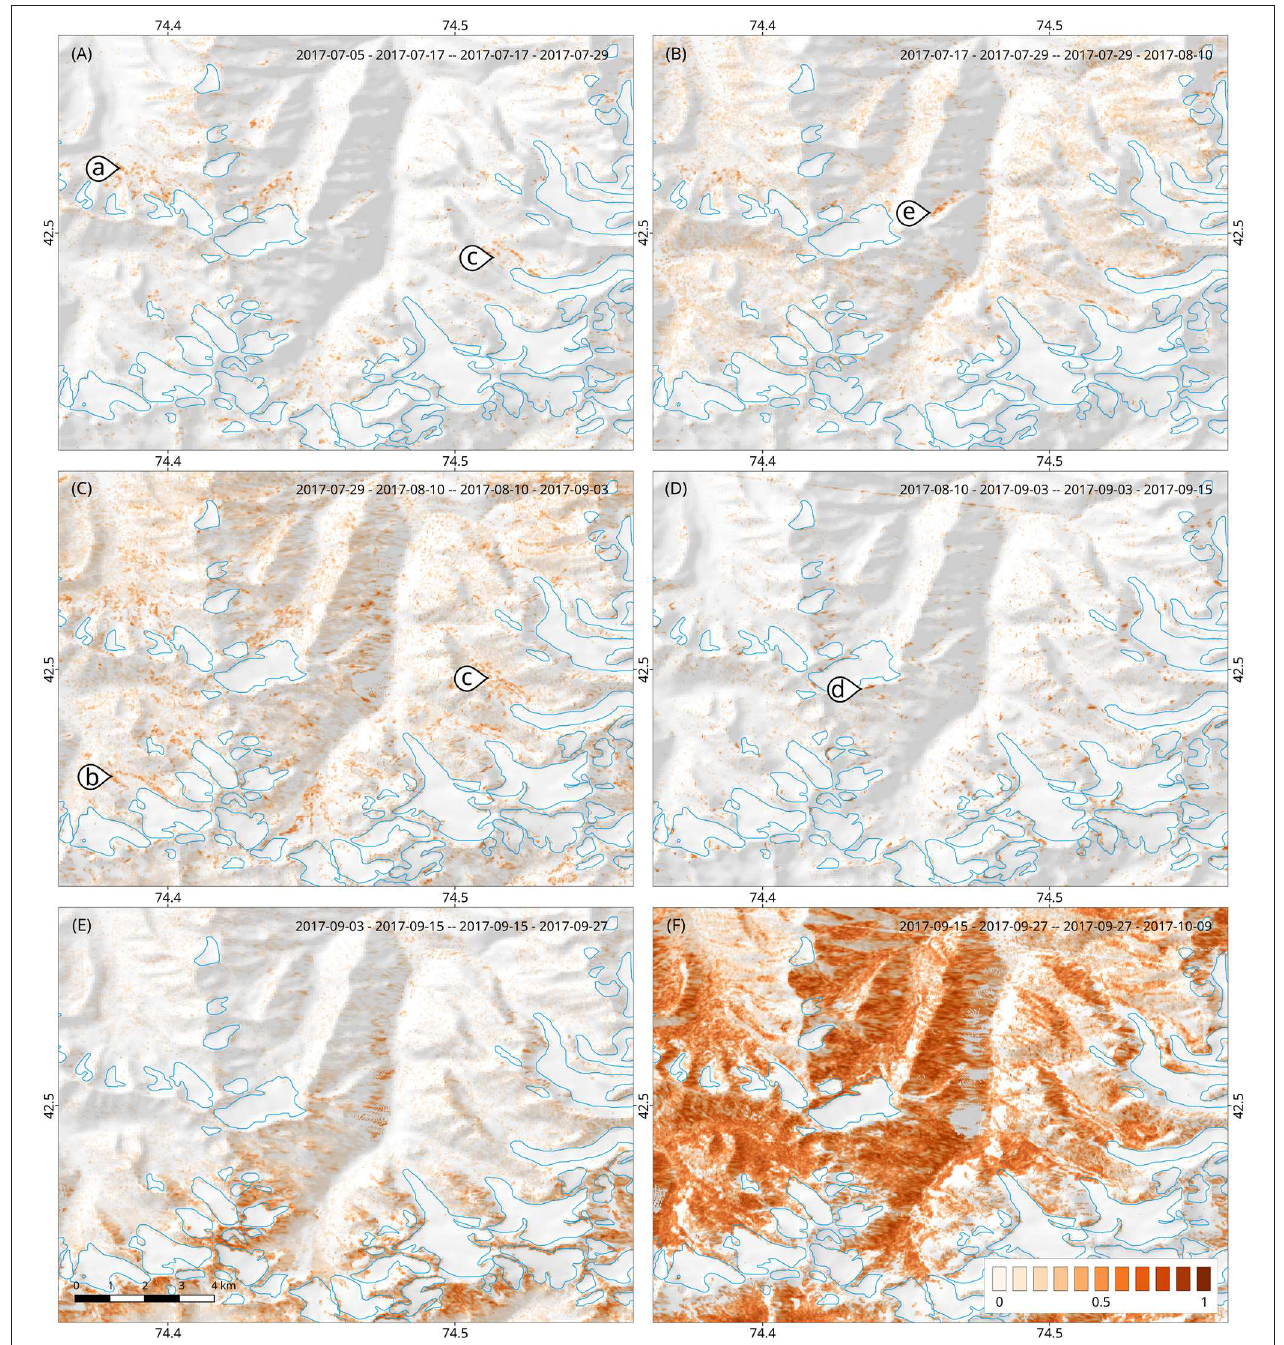
FIGURE 7 | Excerpt of “Unstable Coherence Metric” processing results covering the timespan 2017-07-05 to 2017-10-09 (A–F) . High UCM values indicate areas of significant loss of coherence between two consecutive pairs of scenes. Regions in white to grey colors (hillshade) represent no-data UCM values. Arrows highlight examples of high UCM values that relate to specific landforms of interest: (a) rock glaciers, (b) Little Ice Age moraines, (c) proglacial areas, (d) steep slopes in permafrost areas, and (e) gullies. A semitransparent hillshade based on SRTM DEM data and glacier outlines from Randolph Glacier Inventory v6.0 were added for orientation. Contains modified Copernicus Sentinel data